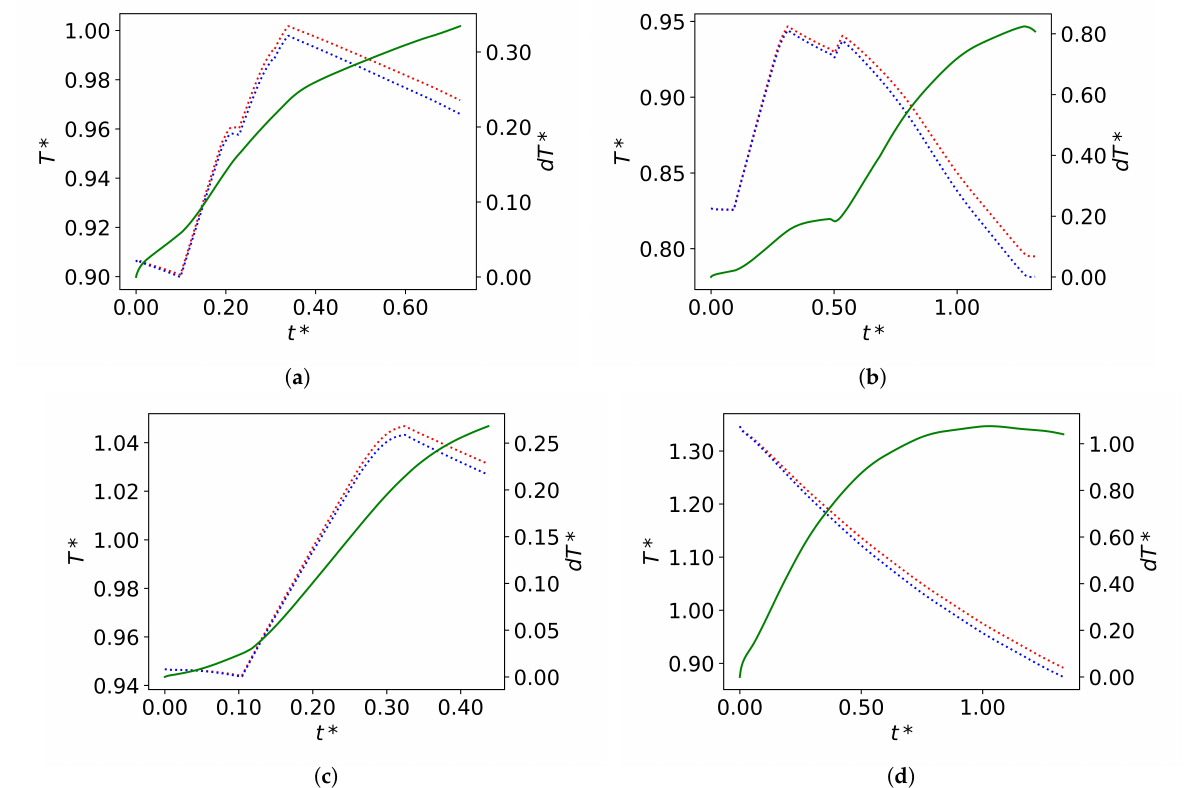
Figure 11. Variation in the maximum, minimum temperatures of the modules and their difference for each case: ( a ) Case 1, ( b ) Case 2, ( c ) Case 3 and ( d ) Case 4; T ∗